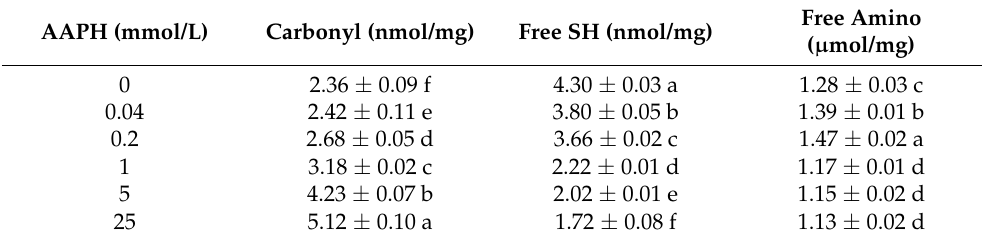
Table 1. Effects of oxidation on the carbonyl group, free sulfhydryl group, and free amino group of walnut samples with increasing concentrations of AAPH a